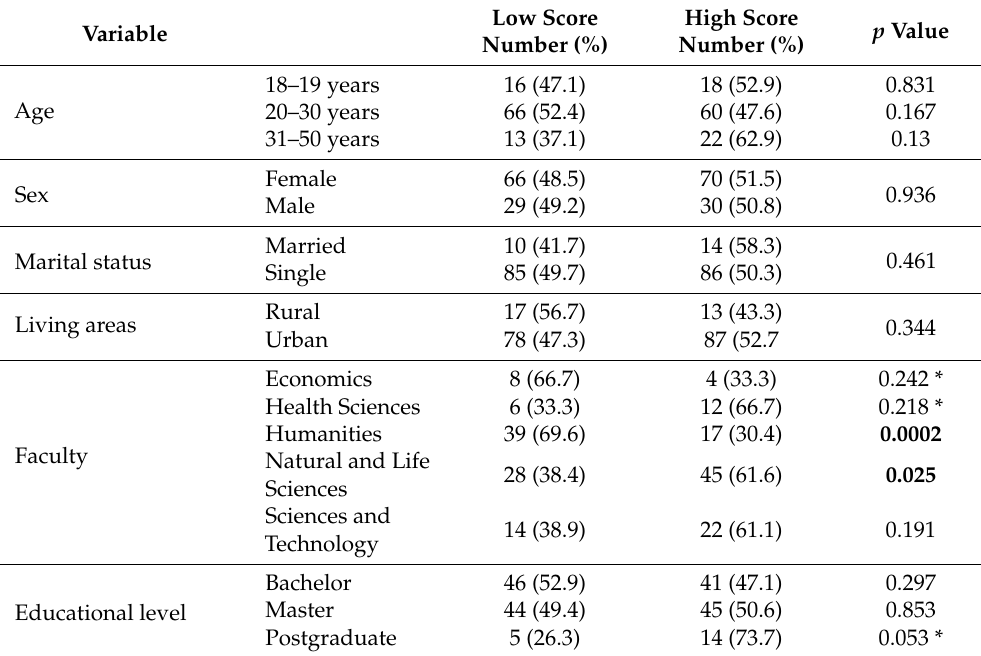
Table 4. Factors associated with the level of knowledge of the study population.